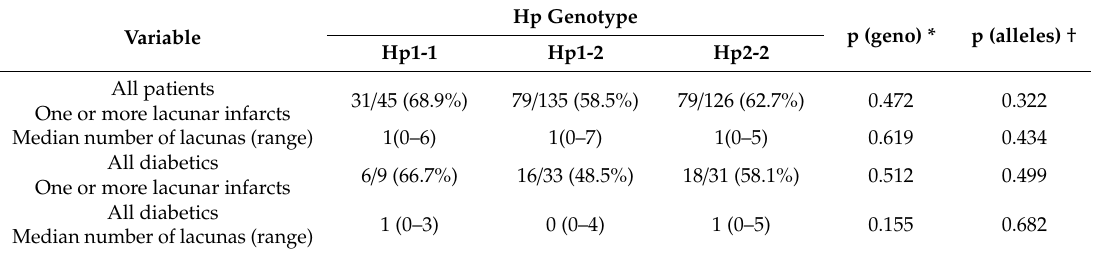
Table 4. Lacunar infarcts in the Helsinki Stroke Aging Memory Study (SAM)